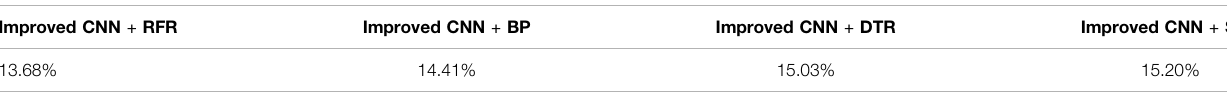
TABLE 3 | The Mean Absolute Percentage Error of different numerical forecasting